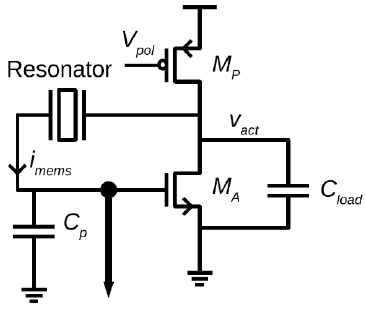
Figure 31. Typical Pierce oscillator configuration [214]. Reproduced with permission from Arndt et al., Sens. Actuators Phys. ; published by Elsevier,